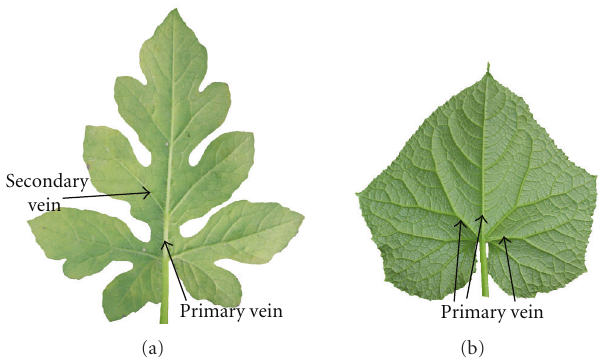
Figure 1: Some examples of venation patterns: pinnate venation (a) and actinodromous venation